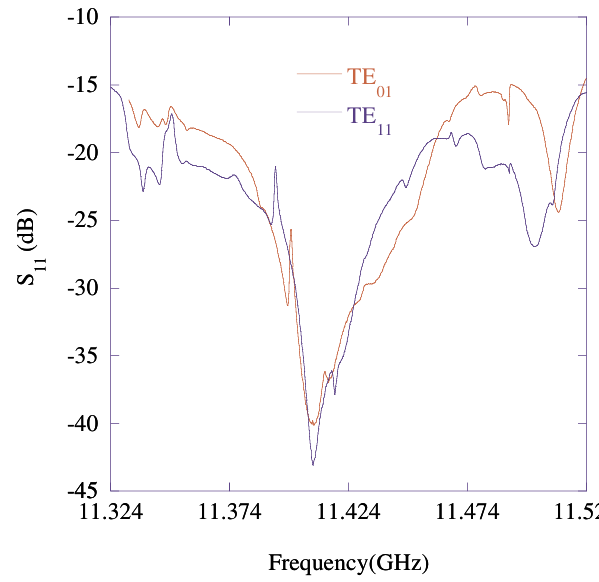
FIG. 13. (Color) The ‘‘load tree’’: a dual-mode high-power load system.